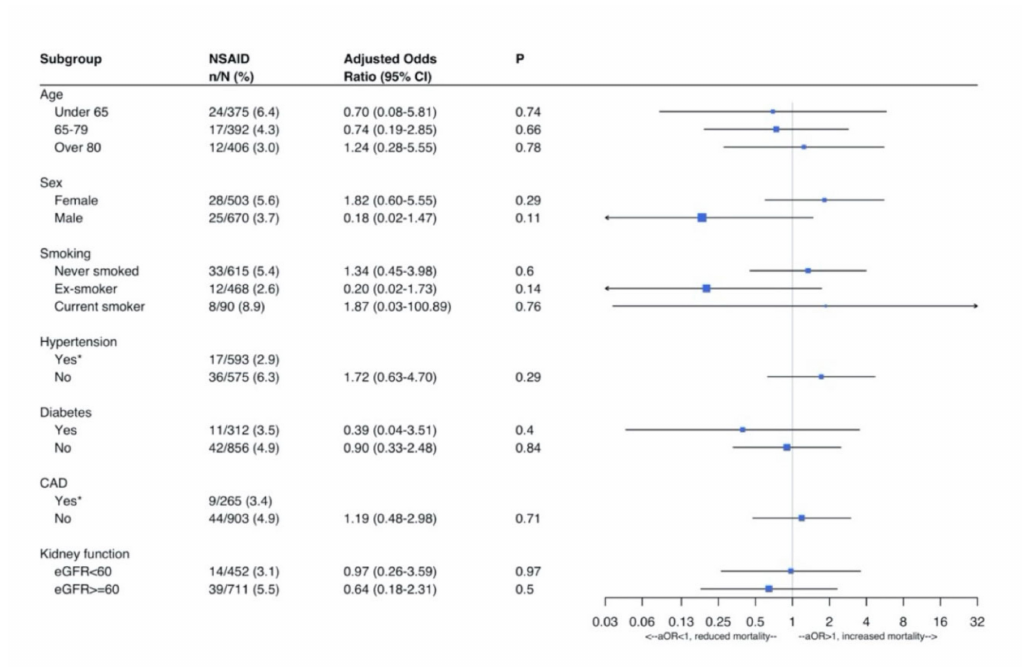
Figure A2. Subgroup analysis, day-7 mortality. Mixed e ff ects logistic regression, presenting the adjusted odds ratio from the logistic regression models. Note: multivariable analyses adjusted for age group, sex, smoking status, hypertension, diabetes, CAD, kidney function and elevated CRP level.